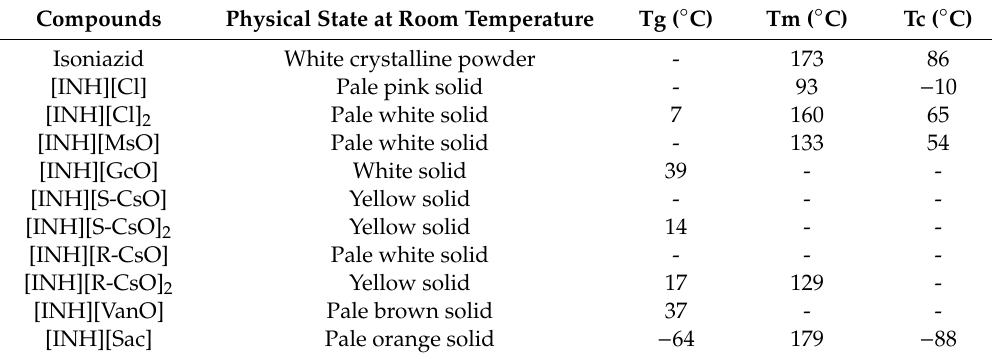
Table 1. Thermodynamic parameters determined for organic salts prepared. Compounds